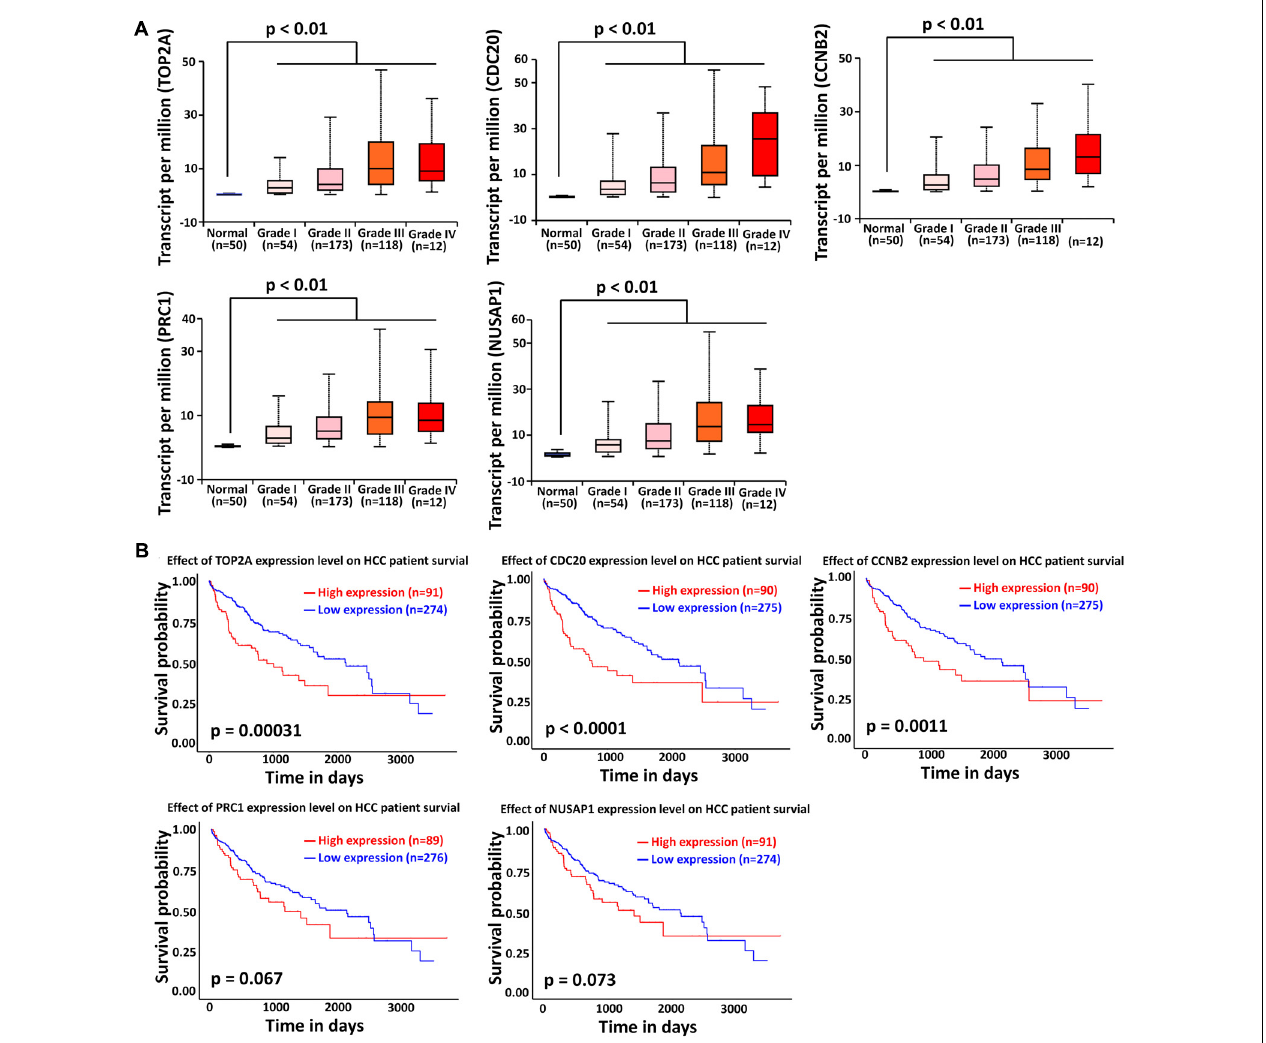
FIGURE 6 | Association of TOP2A, CDC20, PRC1, CCNB2, and NUSAP1 expression with HCC progression and prognosis. (A) Validation of the association between the expression levels of TOP2A, CDC20, PRC1, CCNB2, and NUSAP1 and the pathological stages of HCC (based on TCGA data in UALCAN web-tool). (B) Kaplan–Meier analysis of overall survival in HCC patients in TCGA liver cancer dataset based on TOP2A, CDC20, PRC1, CCNB2, and NUSAP1